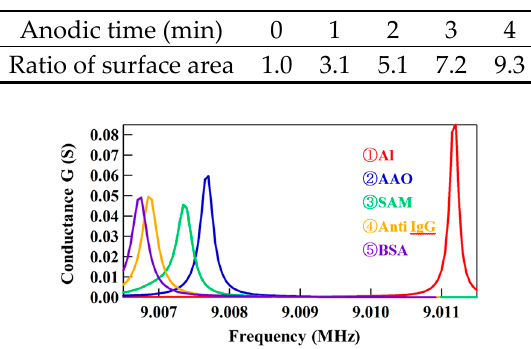
Figure 2. The conductance measurement of the AAO nanostructured QCM chip under applied voltage of 40 V for 4 min for each preparation process.